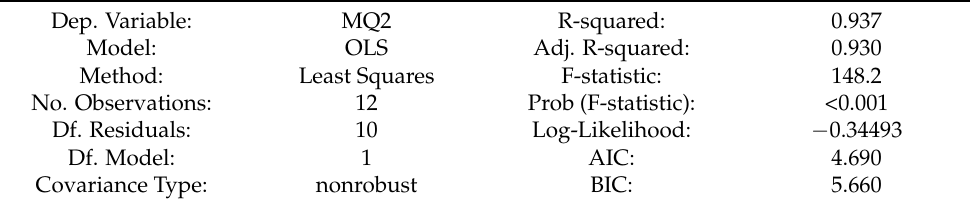
Table 1. OLS regression results (MQ2).